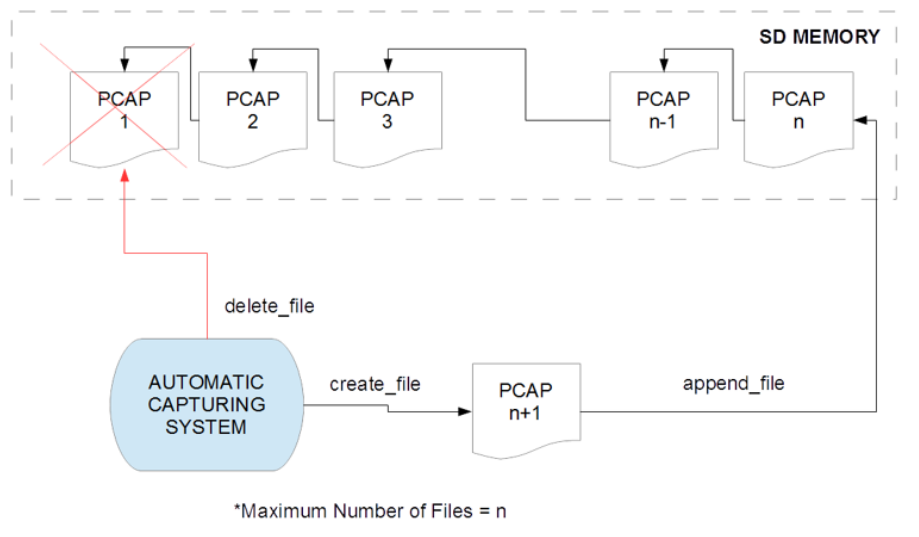
Figure 2. Circular capturing buffers implemented for each communication